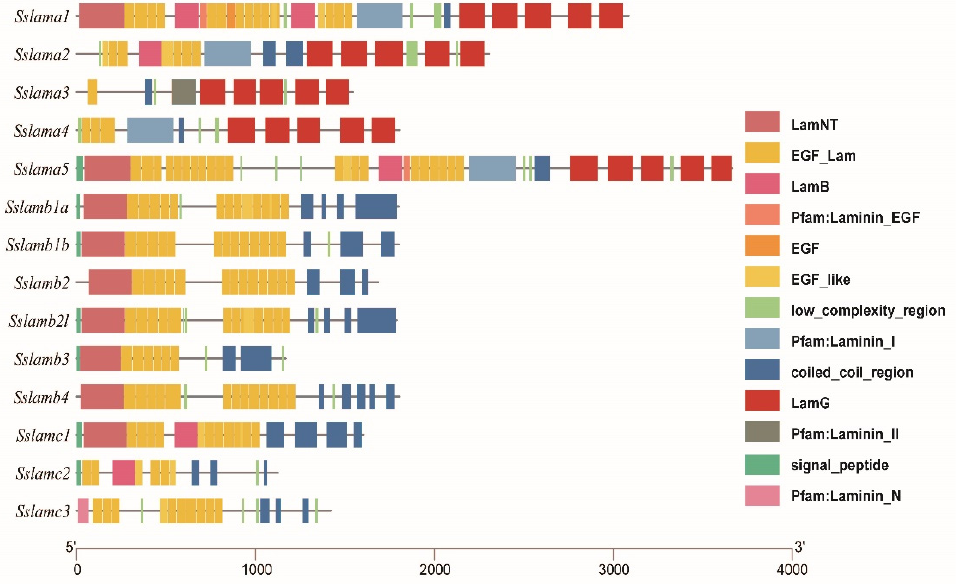
Figure 5. Conserved domains analysis of laminin genes. The number represents the length of the amino acid. Different colors of rectangle represent diverse domains.